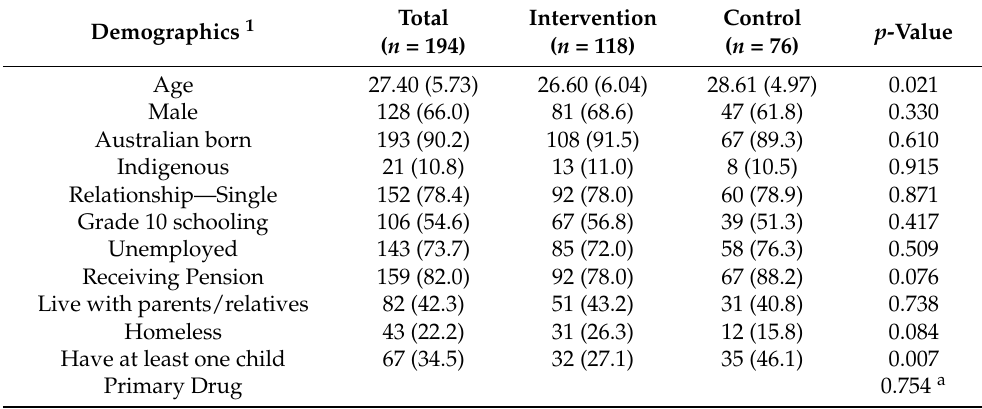
Table 1. Baseline sample